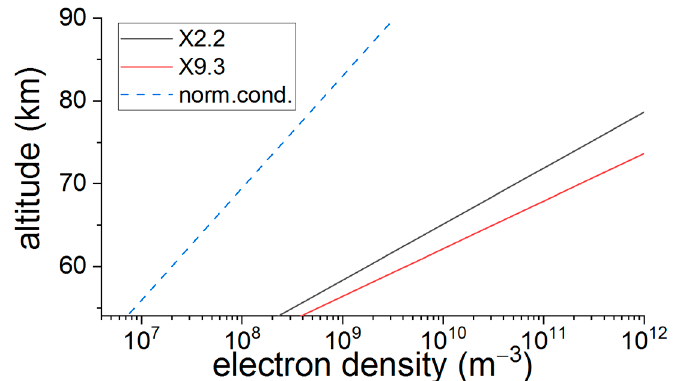
Figure 5. The height profile of electron density at peak time for two successive X-class SFs of 6 September 2017.